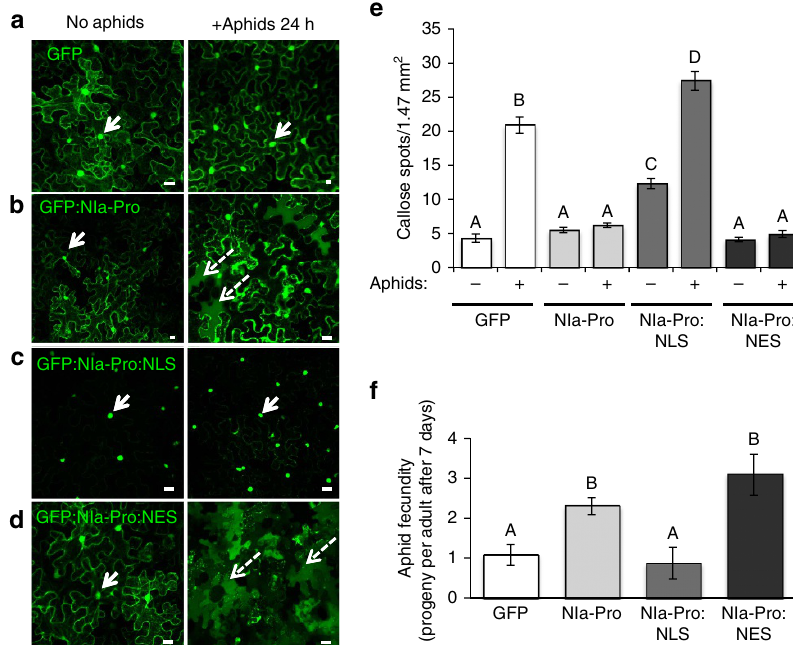
Figure 4 | Relocalization of NIa-Pro is required to increase aphid fecundity. Images show confocal projection of N. benthamiana leaves agroinfiltrated with ( a ) free GFP, ( b ) GFP:NIa-Pro, ( c ) GFP:NIa-Pro:NLS (NLS, nuclear localization signal) and ( d ) GFP:NIa-Pro:NES (NES, nuclear export signal) with or without aphids. ( e ) Callose deposition in agroinfiltrated N. benthamiana leaves with free GFP, GFP:NIa-Pro, GFP:NIa-Pro:NLS and GFP:NIa-Pro:NES with or without aphids infestation. The NLS mutant does not reduce aphid-induced callose accumulation. ( f ) Number of progeny produced by aphids on N. benthamiana agroinfiltrated leaves with free GFP, GFP:NIa-Pro, GFP:NIa-Pro:NLS and GFP:NIa-Pro:NES. (mean ± s.e. of N ¼ 10 for e and N ¼ 8–12 for f ; letters represent significant differences, ANOVA and Tukey’s honest significant difference post hoc , P o 0.05). Results from one of three independent experiments are displayed. Scale bars, 20 m